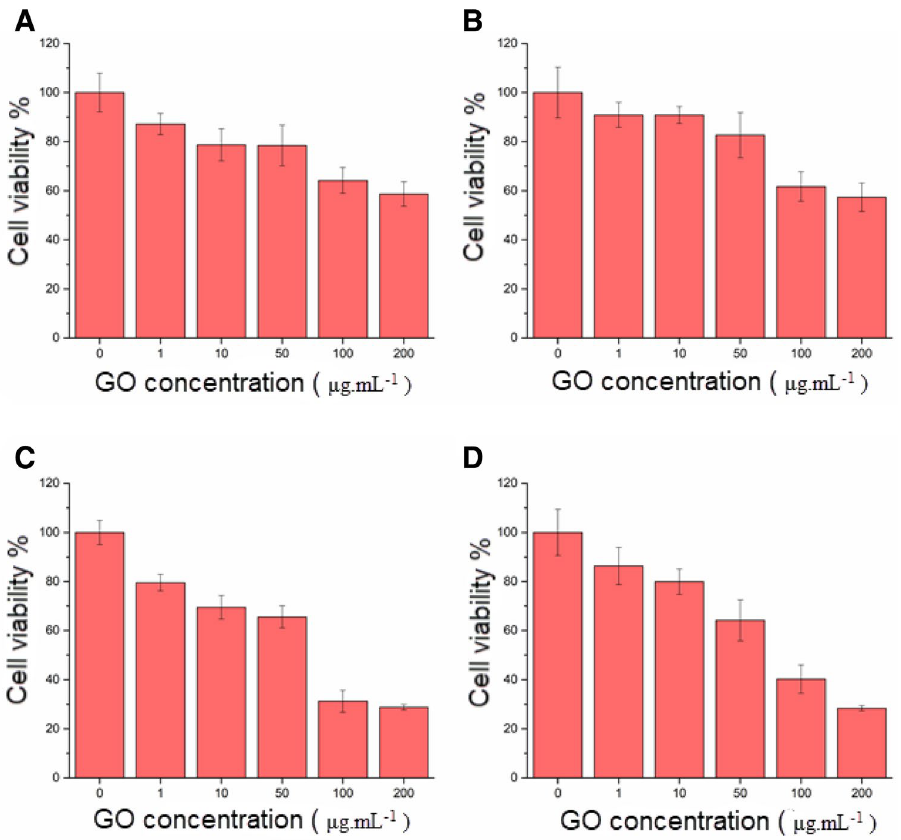
Figure 3. ( A ) The cell viability of MCF-7 cell line after GO nanosheet treated 24 h ( A ) and 48 h ( C ) and the cell viability of MDA-MB-231 cell line after GO nanosheets treated 48 h ( B ) and 24 h ( D ), The data represent the mean ± standard deviation of cell viability of MCF-7 and MDA-MB-231 cell lines obtained from four independent